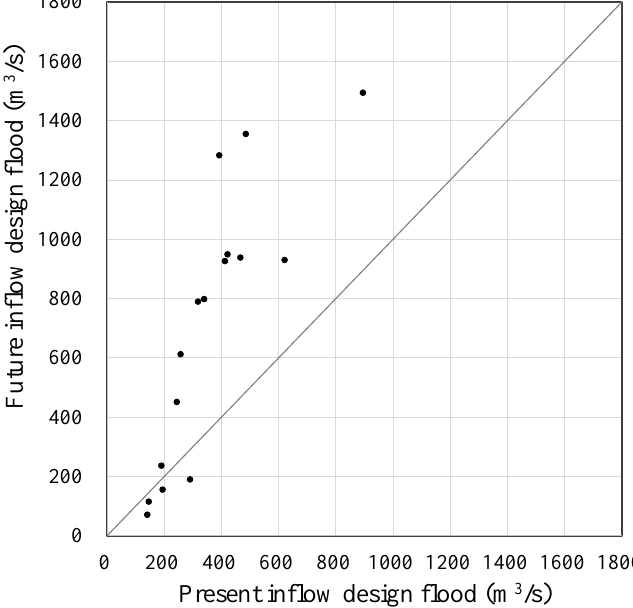
Figure 7. Scatter plot between the present and future inflow design floods (2100s) for a 200-y return period for 30 agricultural reservoir watersheds. The solid gray line is the 1:1 line.